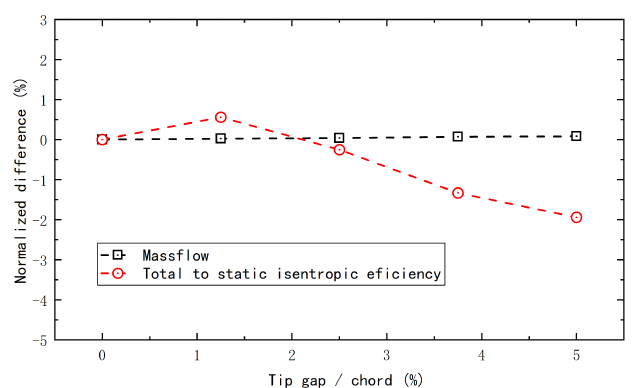
Figure 4. Normalized difference in mass flow and total to static isentropic efficiency of the five rotor models.